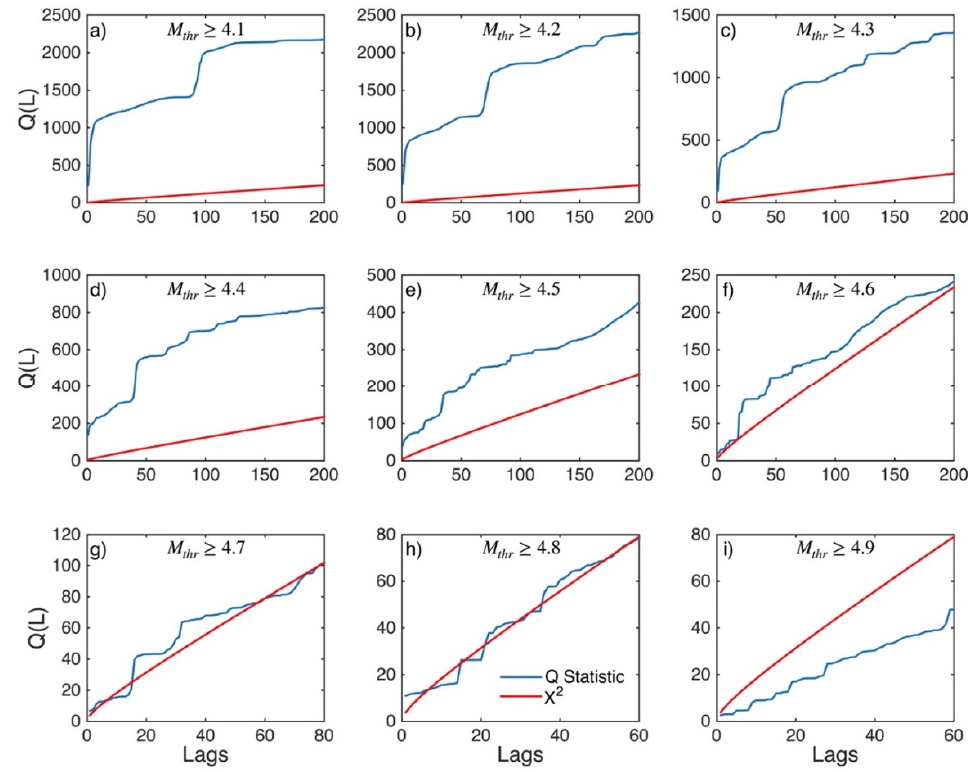
Figure 5. Statistics of Ljung–Box Q-test (blue lines) and the critical values for the X 2 distribution (red lines) for central Ionian Islands (sub-area 2) for magnitude thresholds ( M thr ) varying from 4.1 to 4.9 (subplots a – i ).